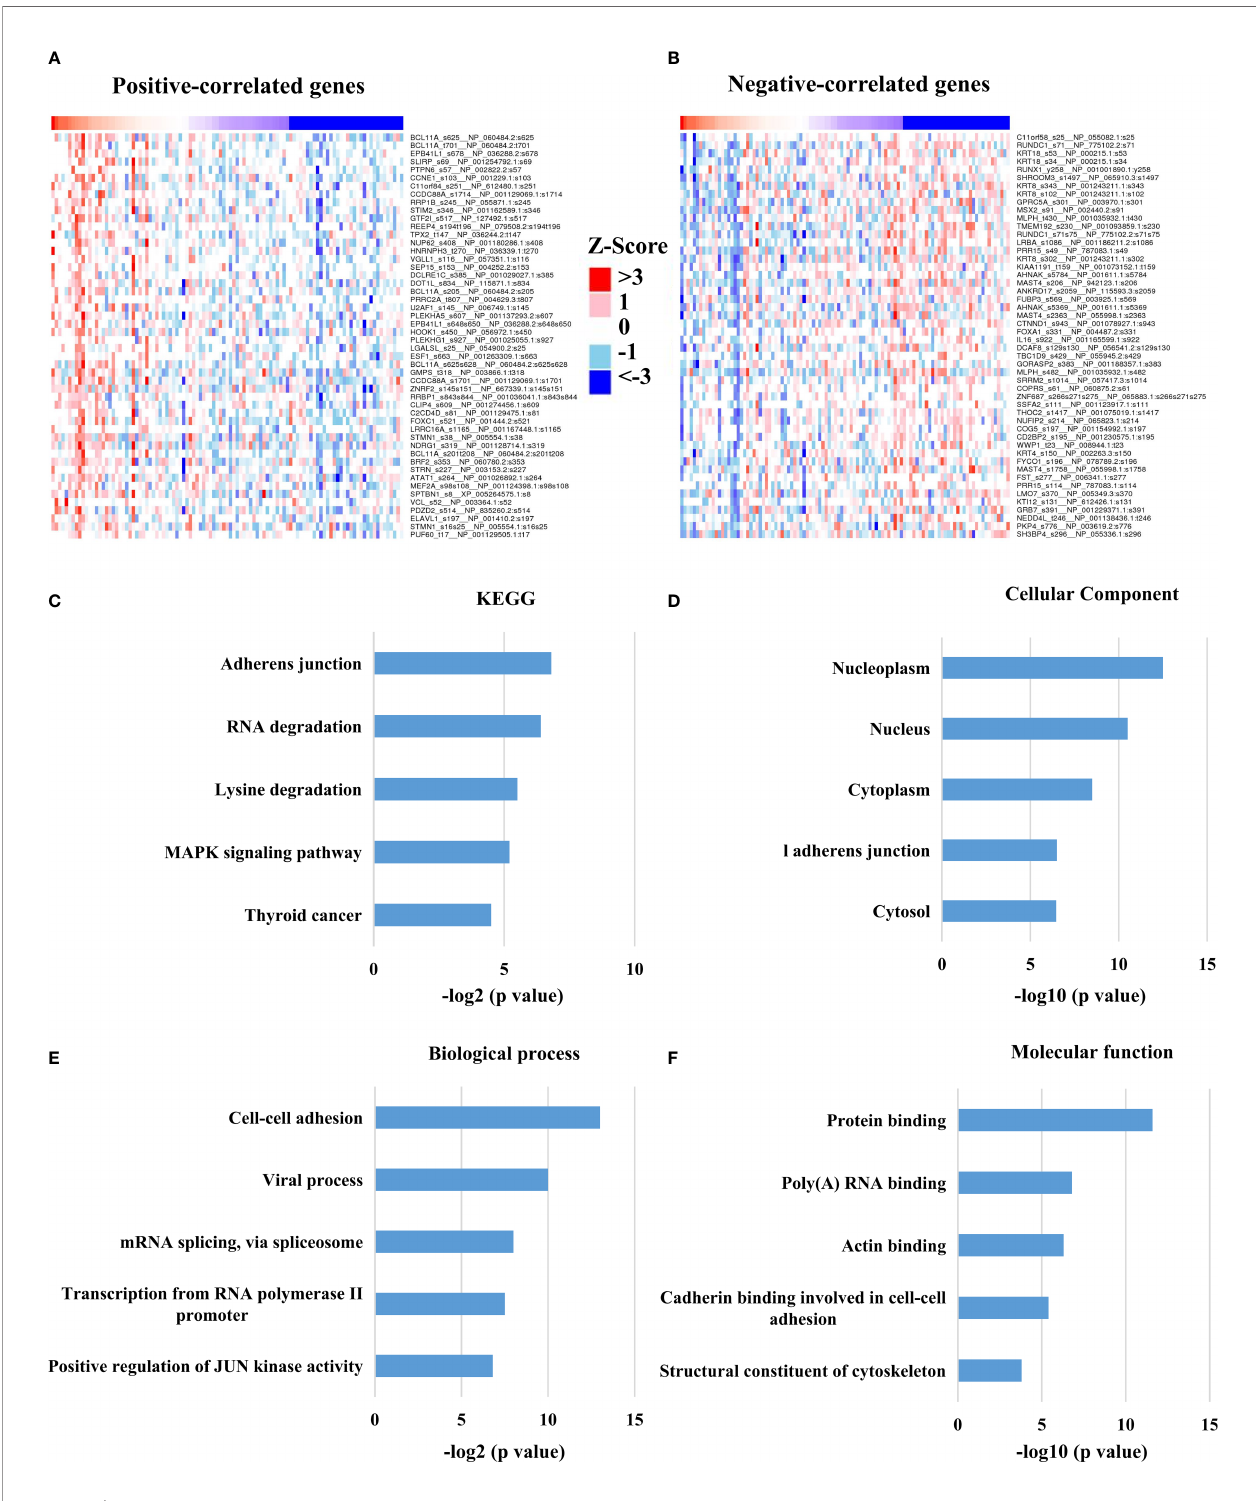
FIGURE 3 | HTR6 was potentially involved in the regulation of MAPK, JUN and immune pathways in breast cancer. (A) The top 50 phosphorylation proteins positively correlated with HTR6 mRNA; (B) The top 50 phosphorylation proteins negatively correlated with HTR6 mRNA. 294 HTR6 co-expressed phosphorylated proteins (correlation coef fi cient > 0.3 or < -0.3) were enriched by (C) KEGG, (D) Cellular component, (E) Biological process, and (F) Molecular